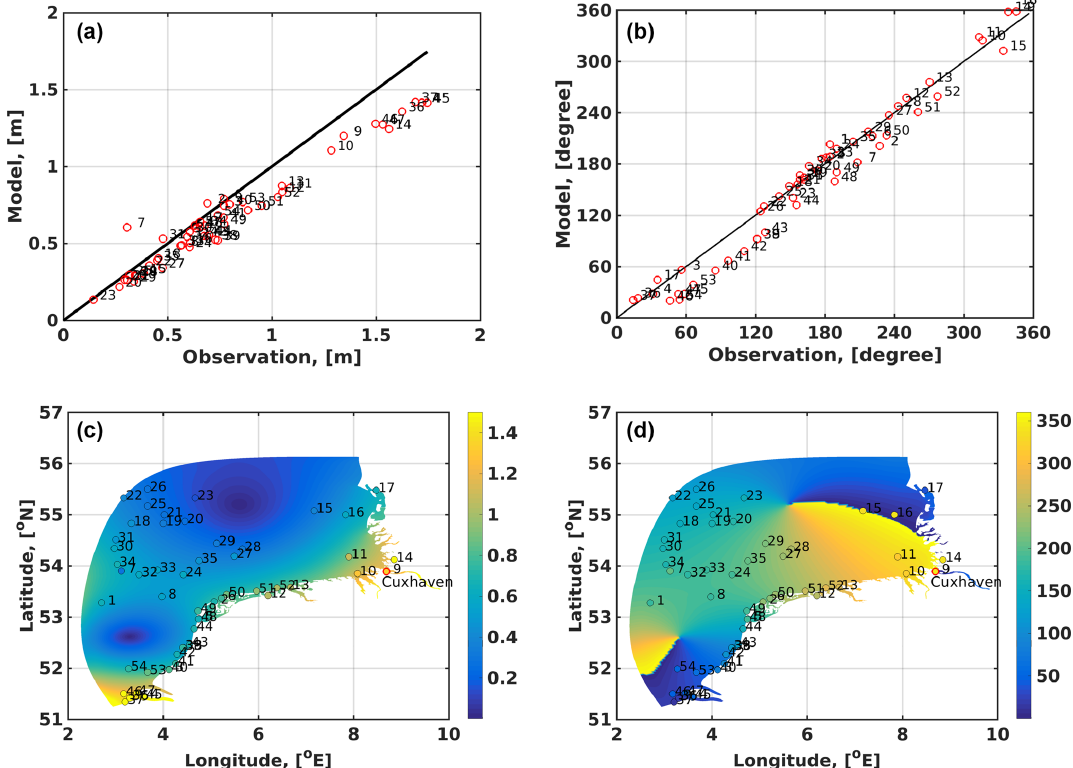
Figure 11. The simulated M 2 tidal map in the south North Sea experiment compared to observations. The amplitude is in meters (a, c) and phase (b, d) in degrees. (a, b) Model-to-observation graphs; the numbers correspond to station numbers shown in (c, d) . The color shows the amplitude in (a) and phase in (b) , and the filled circles show the observational data. The red circle indicates the position of Cuxhaven station. The total vector error is 0.24m for 53